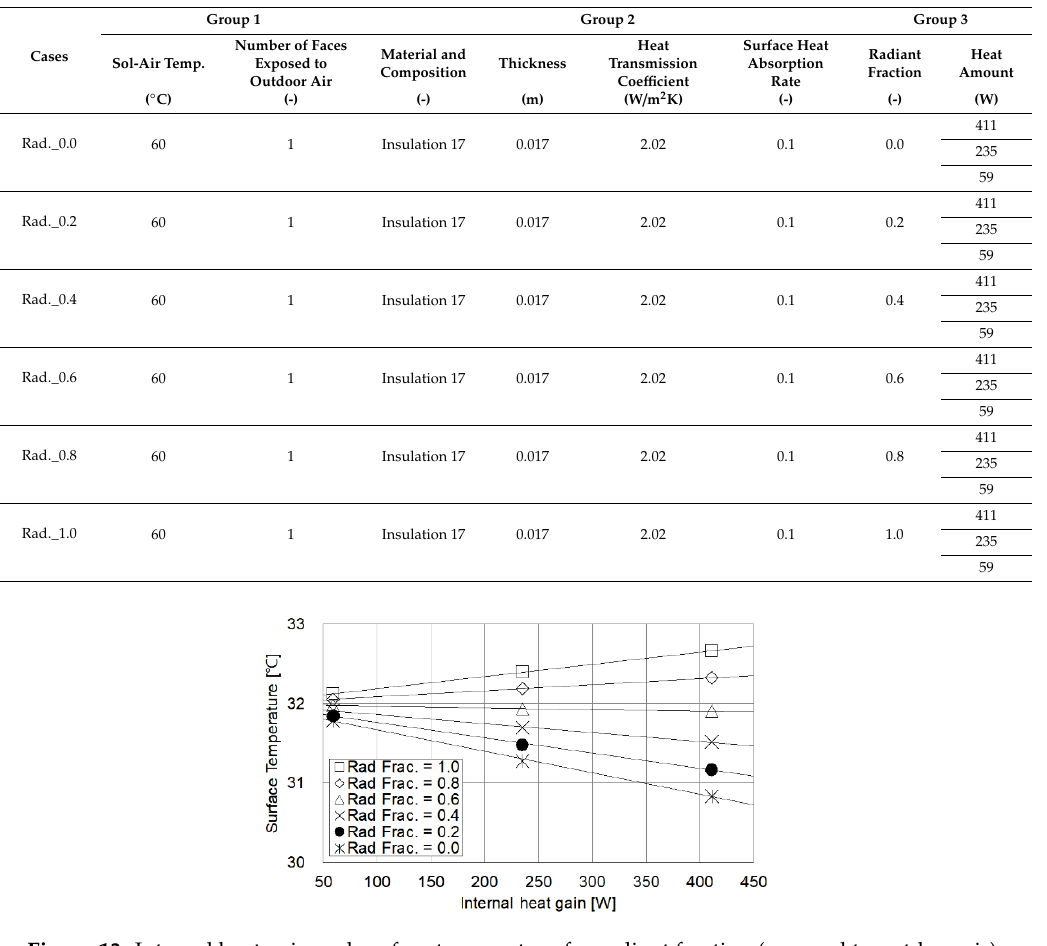
Table 14. Cases for component of internal heat gain (exposed to outdoor air).